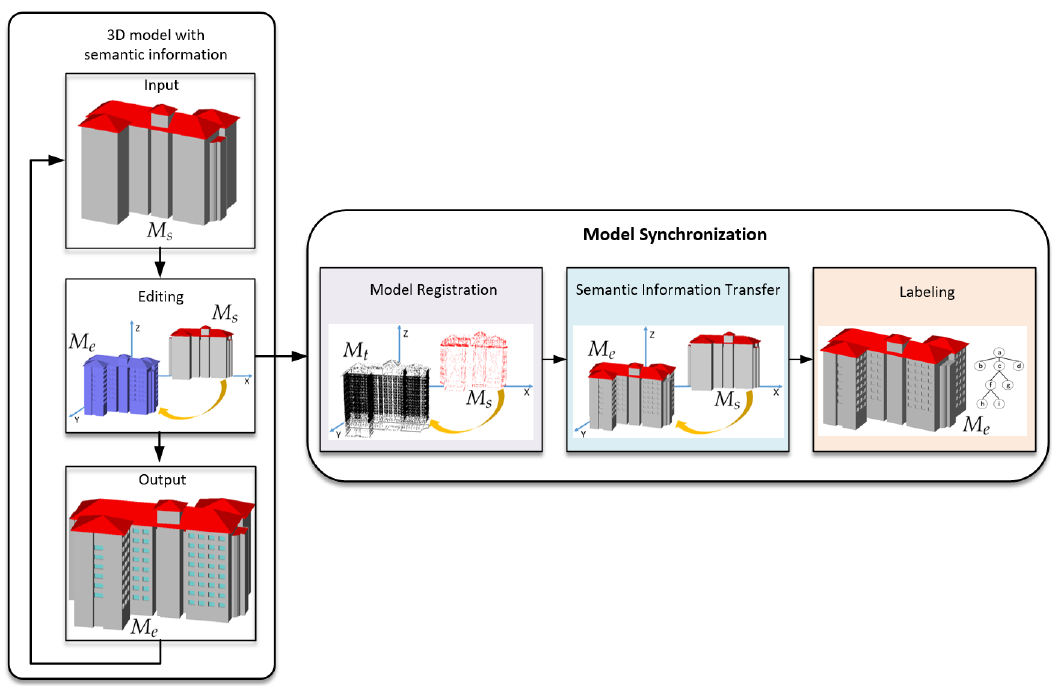
Figure 1. Flow chart of automatic 3D model